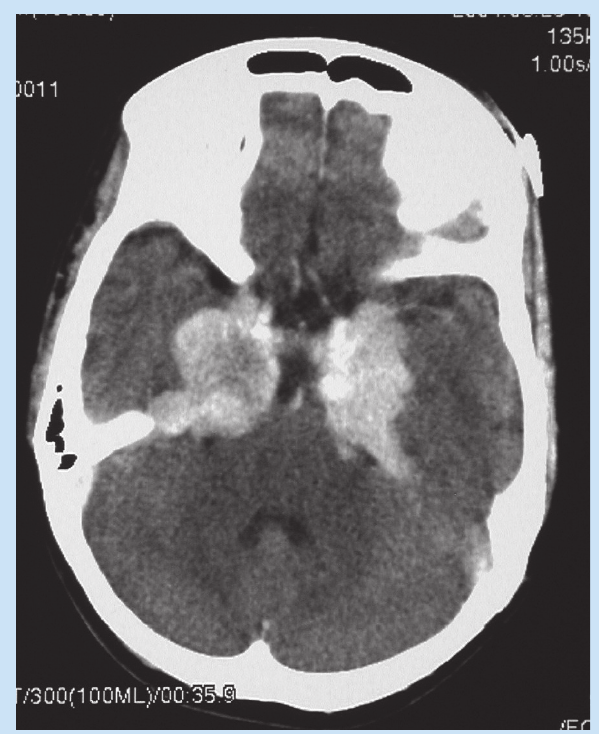
Fig. 3a. Pre-contrast image showing bilateral hyperdense cavernous meningiomas extending into the suprasellar areas.